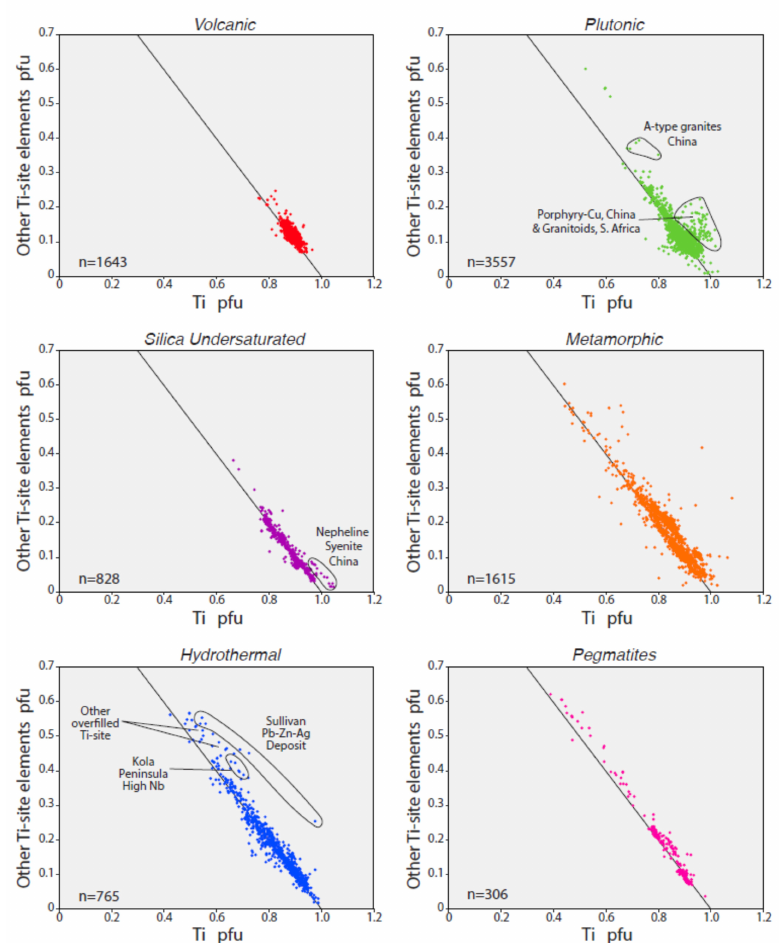
Figure 2. Ti vs. the sum of all other Ti-site elements (mainly Fe, Al, Nb, Ta, Mg, Zr, Sn, and to a lesser extent V, Cr, U, and Th) in titanite from various environments. The number of analyses (n) in each group is shown. A few outliers are identified and labeled. The anomalous A-type granites from China are peralkaline